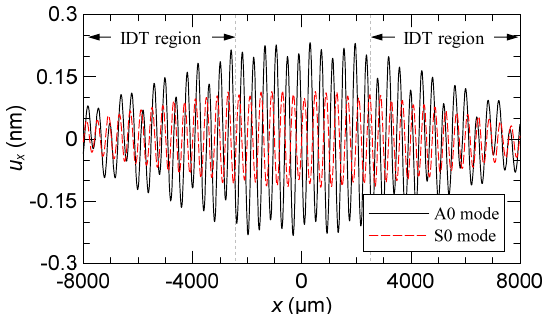
Figure 4. Comparison of the calculated tangential surface displacement component u x between the standing A0 and S0 modes excited by the double IDTs.